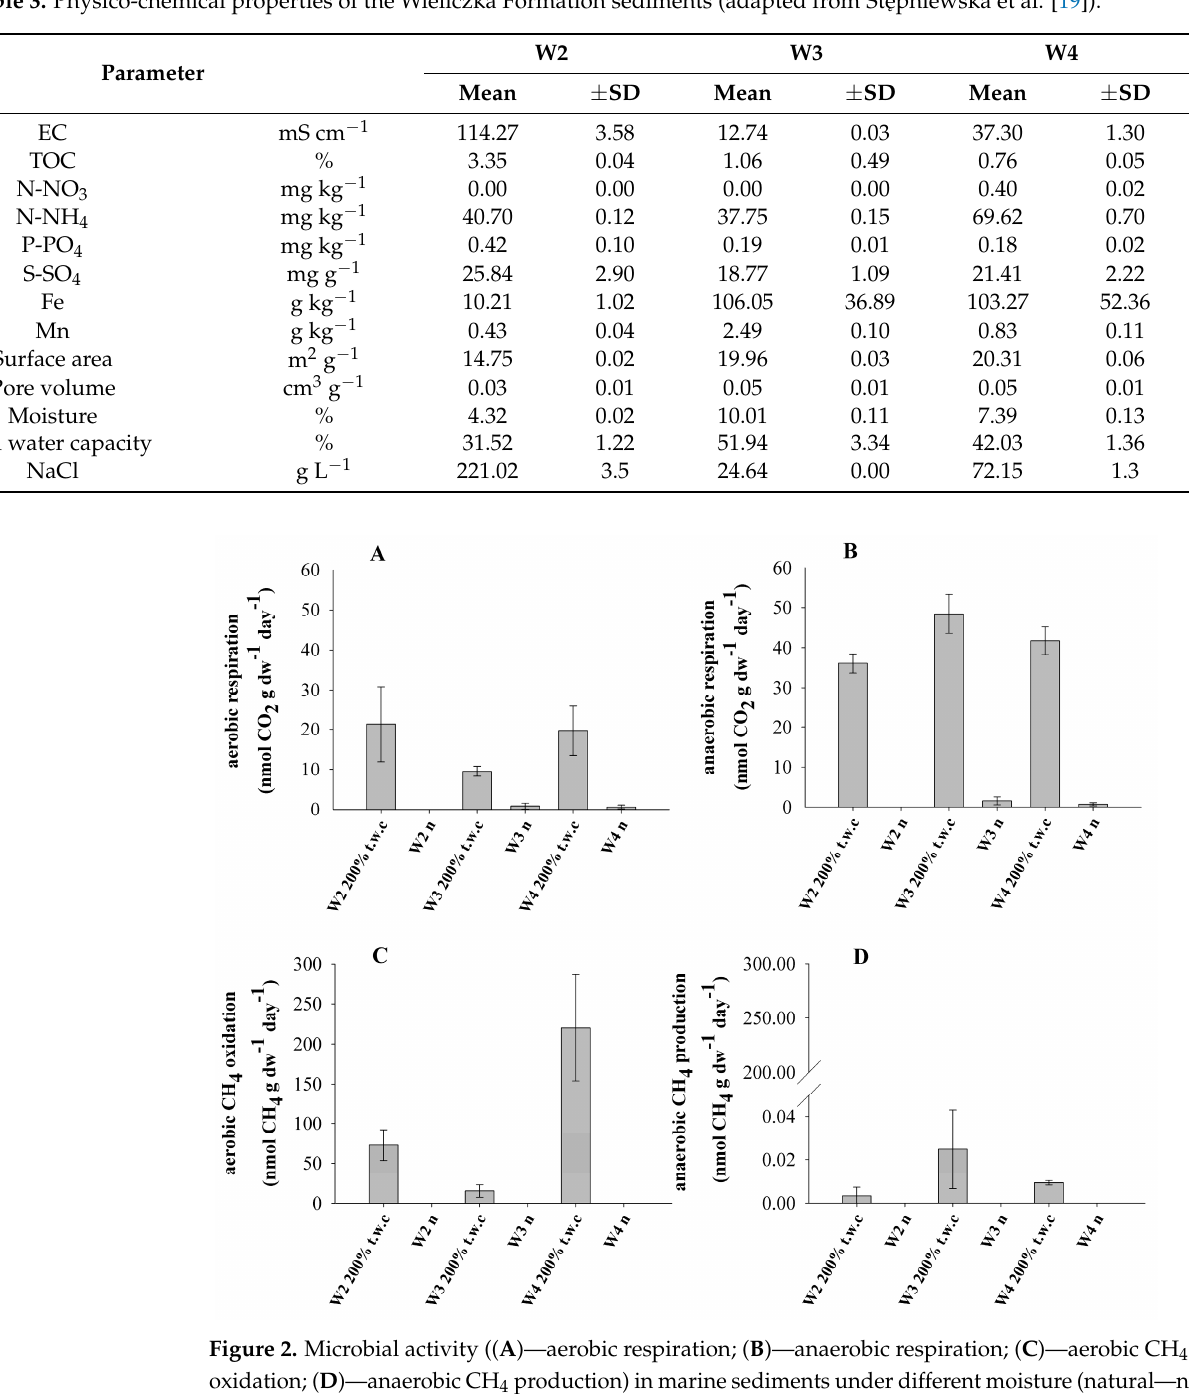
Table 4. Sequence alpha diversity and richness estimators of microbial communities.